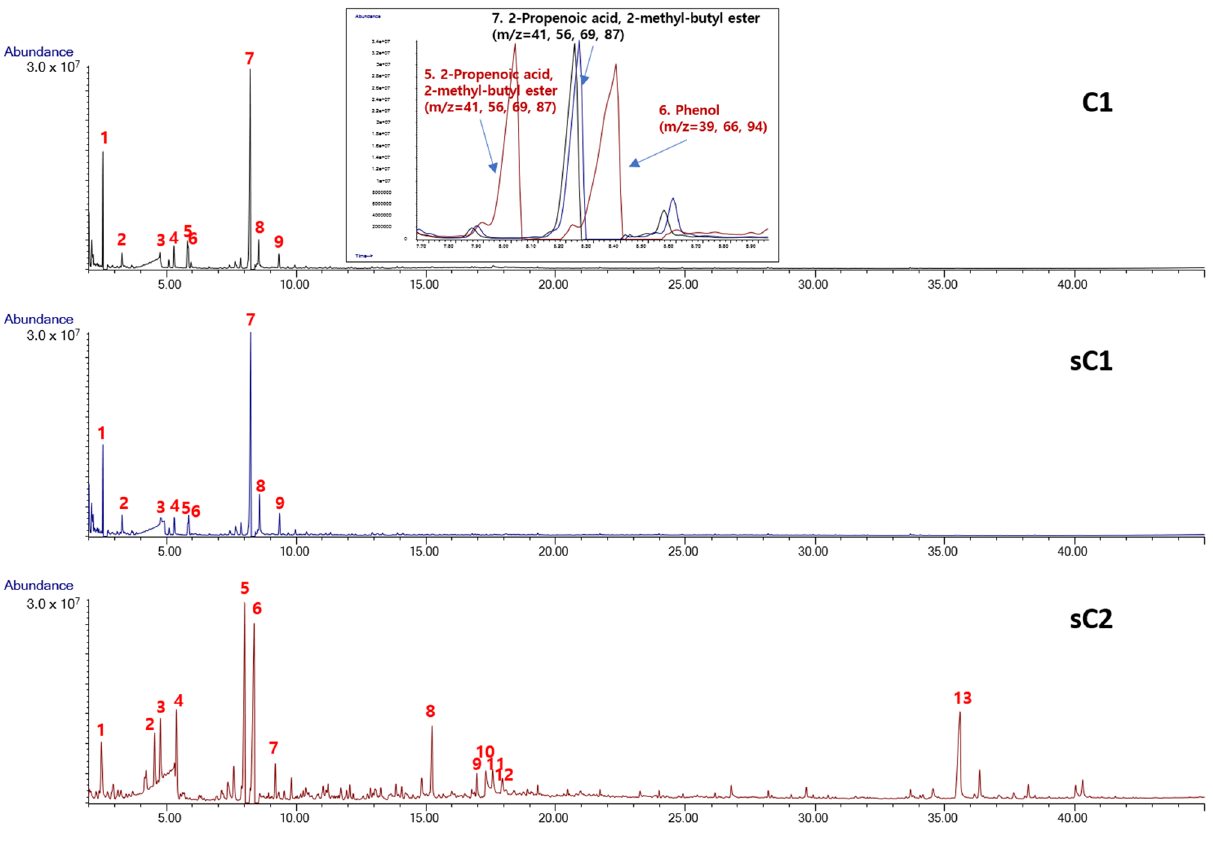
Figure 7. Py–GC/MS spectra of Case III evidence.